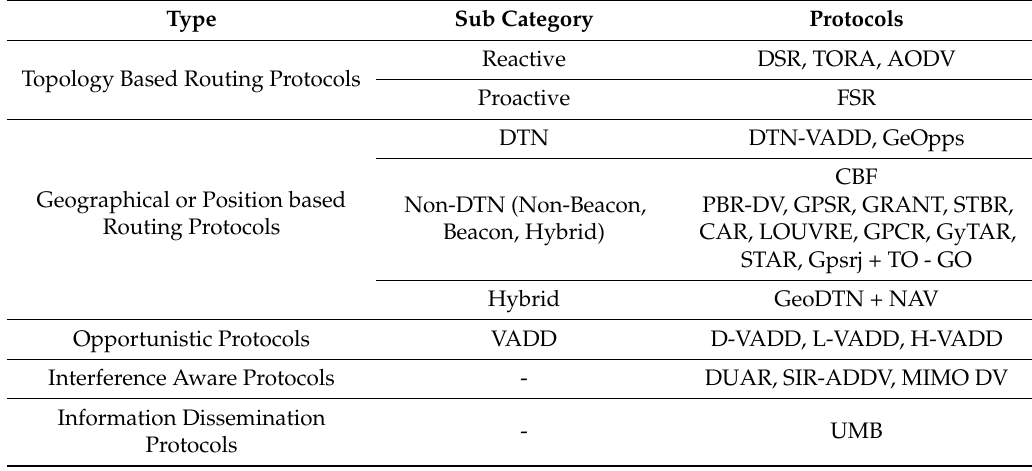
Table 3. Routing